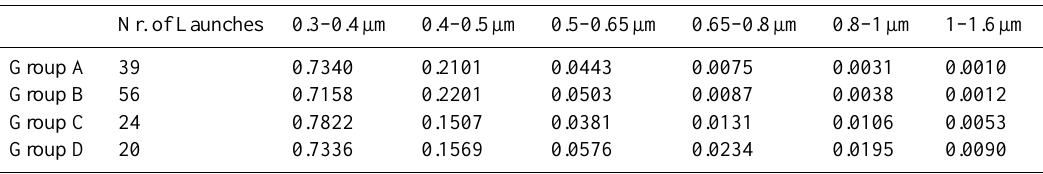
Table 6. Average size distribution in the homogeneous groups.